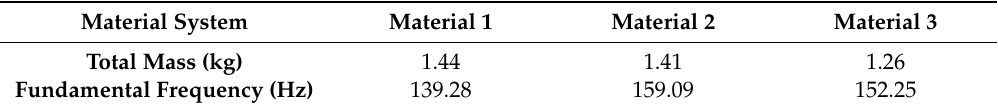
Table 2. The total masses and modal frequencies of the three plates.